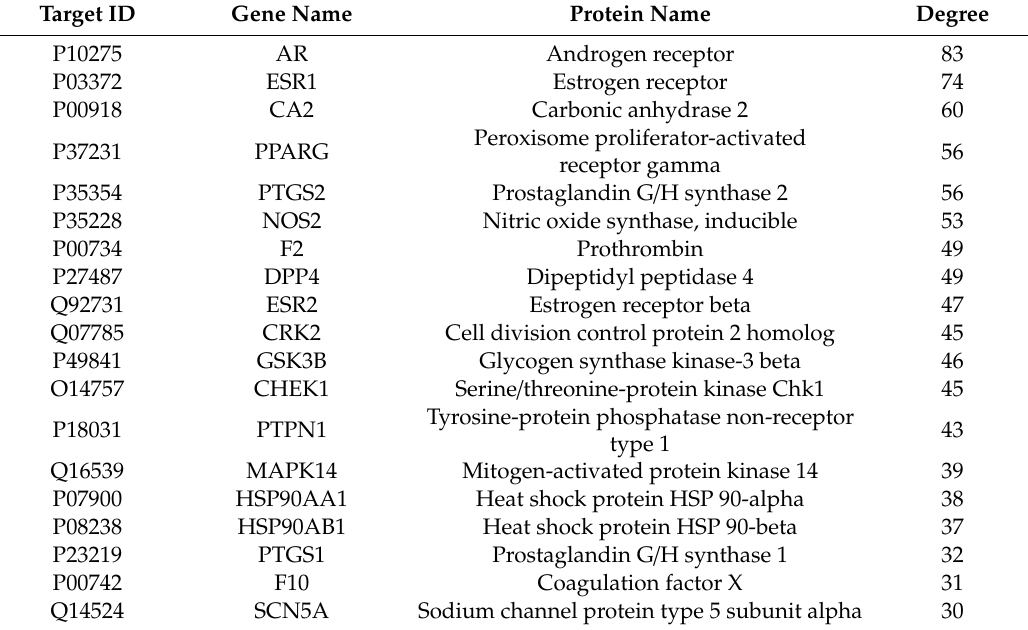
Table 3. The Topological Properties of